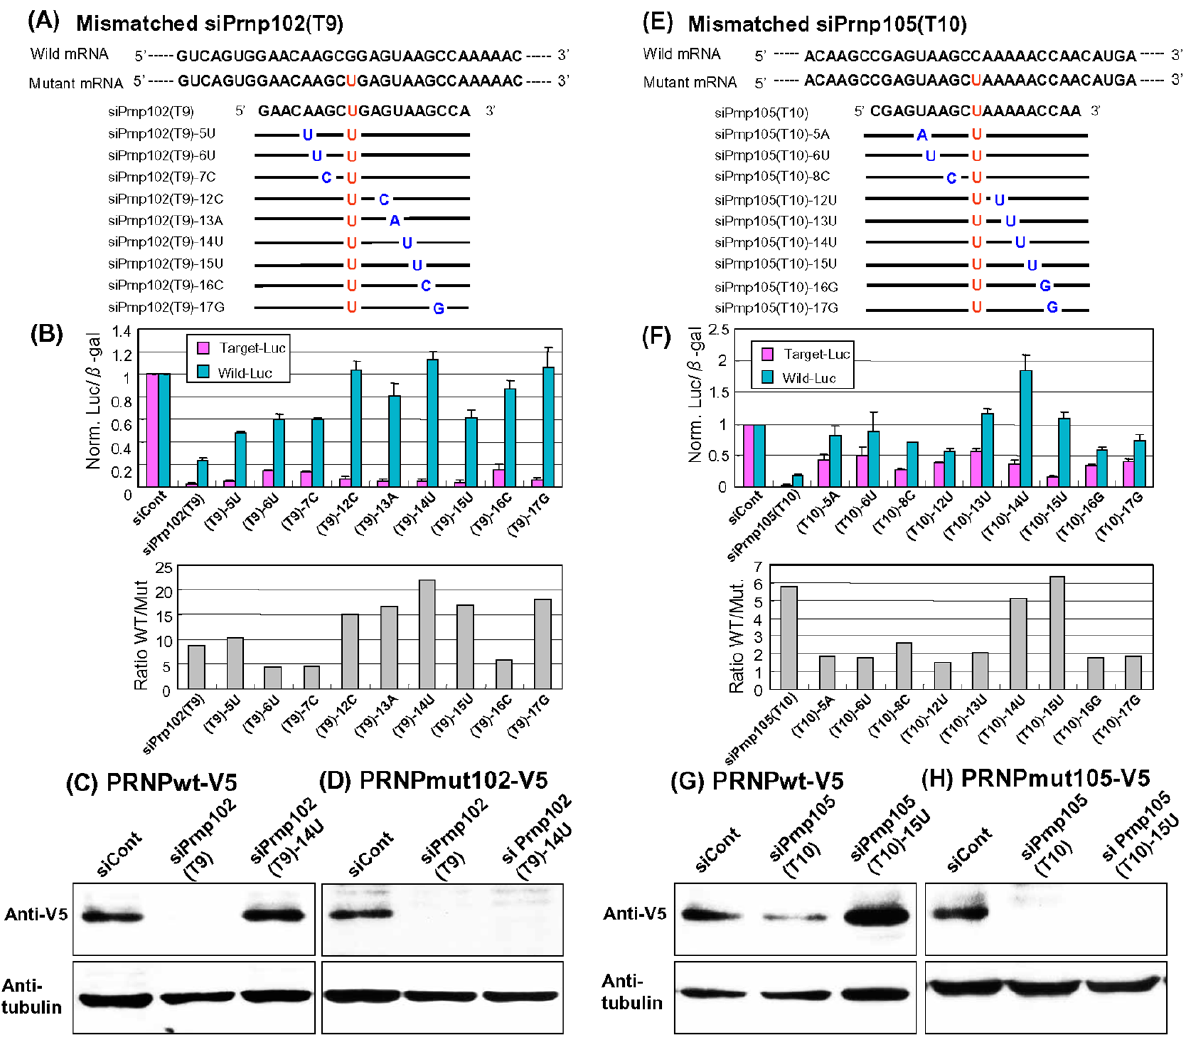
Figure 2. Assessment of mismatched siPrnp102(T9) and siPrnp105(T10) duplexes on ASP-RNAi. (A, E) Nucleotide sequences of wild-type and mutant PRNP mRNAs and designed siRNAs. The wild-type and mutant PRNP mRNA sequences around the P102L (A) and P105L (E) variations are shown and the variations are indicated in red. Designed siRNAs (indicated) are represented based on the sequence of the sense-strand (passenger) siRNA element; mismatched nucleotides (introduced base substitutions) and the original variations are indicated in blue and red, respectively. The same sequences as the siPrnp102(T9) or siPrnp105(T10) are represented by thin lines. (B, F) Effects of mismatched siPrnp102(T9) and siPrnp105(T10) on ASP-RNAi. Mismatched siPrnp102(T9) (B) and siPrnp105(T10) (E) duplexes (indicated) were examined as in Figure 1. The ratio of wild-type allele- luciferase activity against the mutant allele-luciferase activity (WT/Mut) was also examined to evaluate the improvement in ASP-RNAi. Data are averages of at least three independent determinations. Error bars represent standard deviations. Expression of the wild-type (C, G) and mutant [P102L (D) and P105L (H)] PRNP polypeptides (PRNPmut102-V5 and PRNPmut102-V5) in the presence of indicated siRNA duplexes was investigated by Western blotting using anti-V5 antibody. Expression of a -tubulin was examined as the